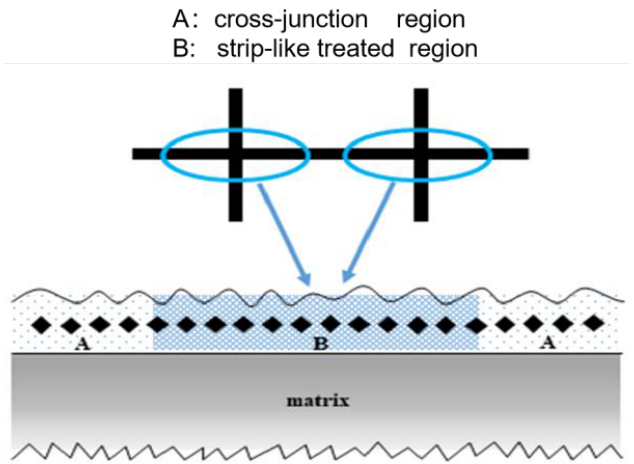
Figure 3. Schematic diagram of microhardness measurement in areas A and B in the vertical direction of laser processing.